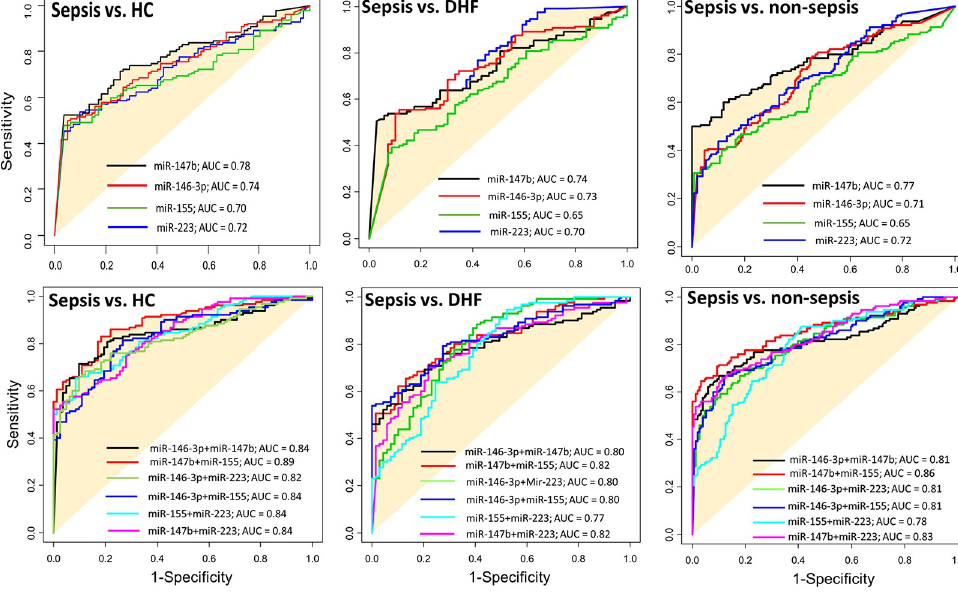
Fig 3. The value of miRNAs’ in differentiating diagnosis bacterial sepsis and non-sepsis groups. Diagnostic performance of the models built based on random forest models with single or double combination of miRNAs in differentiating sepsis patients from other groups HC, DHF and